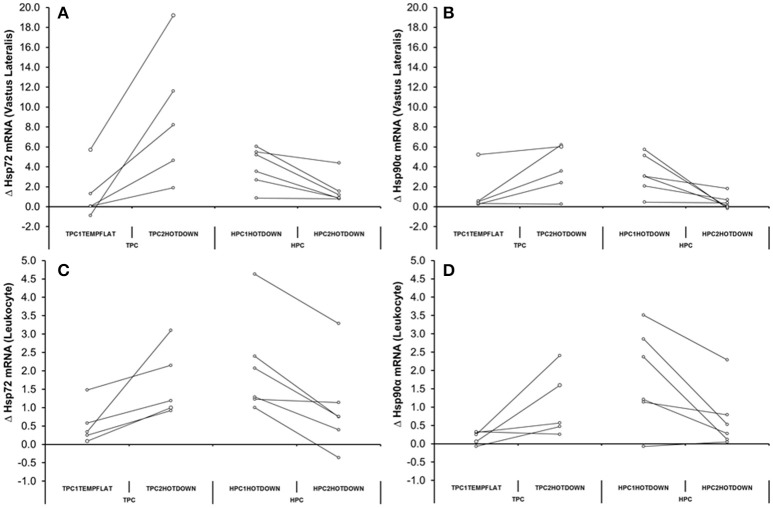
Individual responses reflecting the change in mRNA (A = Hsp72 mRNA in Vastus Lateralis, B = Hsp90α mRNA in Vastus Lateralis, C = Hsp72 mRNA in Leukocytes, DS Hsp90α mRNA in Leukocytes) from baseline to immediately post TPC1TEMPFLAT and TPC2HOTDOWN
(A,C), and HPC1HOTDOWN and HPC2HOTDOWN
(B,D).